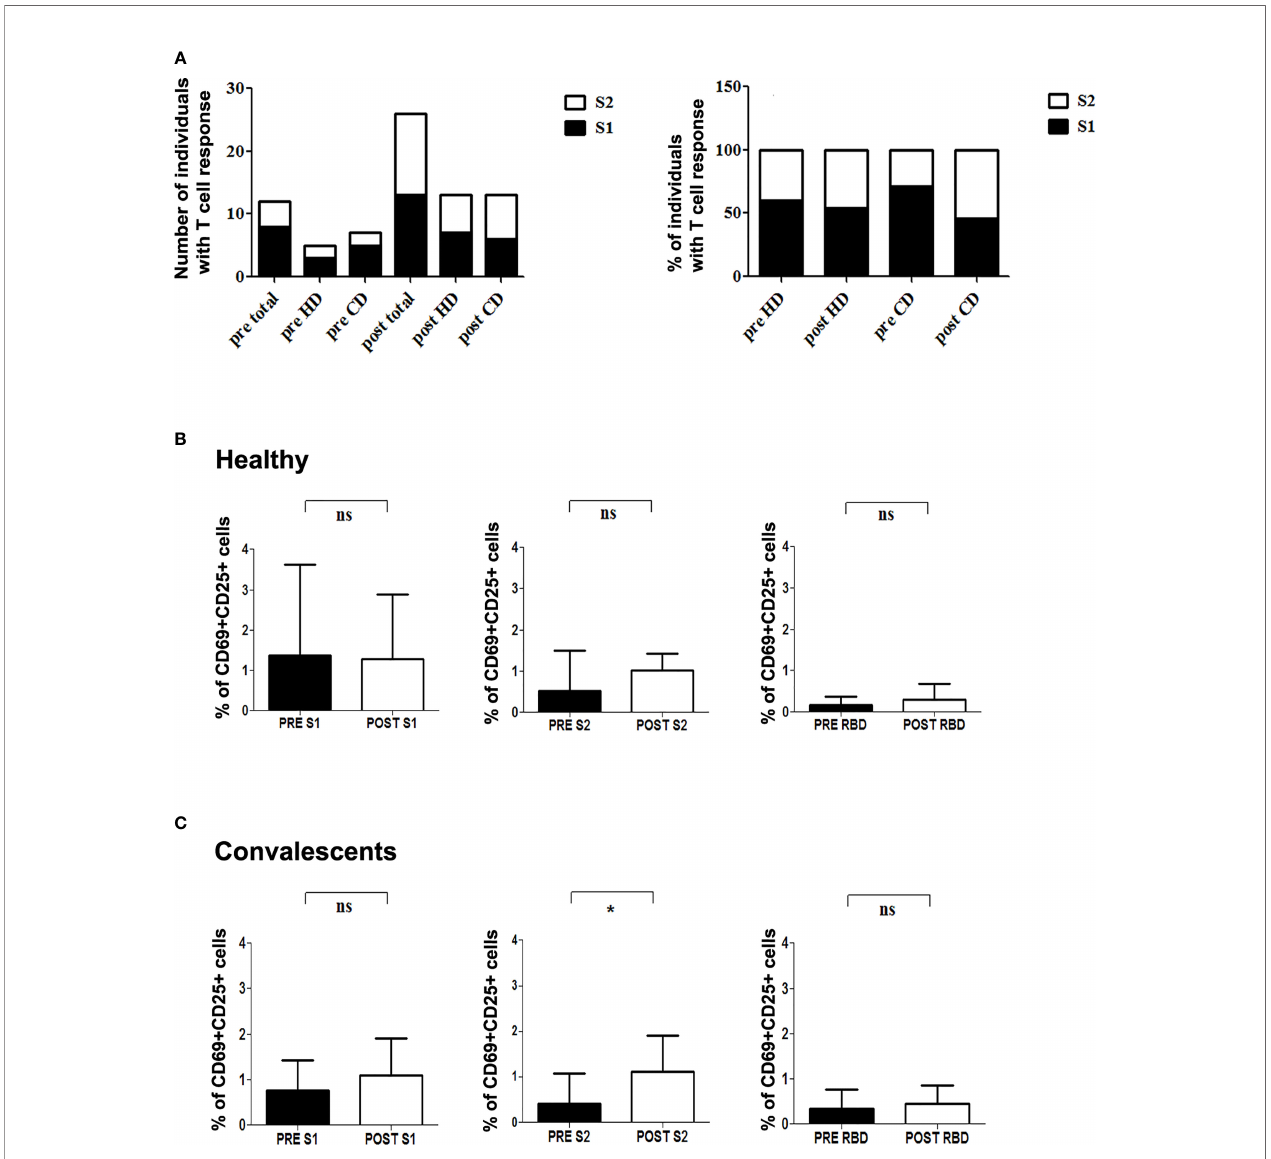
FIGURE 3 | T cell reactivity to SARS-CoV-2 S protein in healthy and convalescent individuals before and after vaccination. (A) Left , absolute number of individuals with CD4+ reactive lymphocytes against S1 (black) and S2 (white) before (pre) and after (post) vaccination. Right , Relative percentage of S-protein positive donors reactive for either S1 (black) or S2 (white) in each condition. (B, C) Graphics show speci fi c percentage of HD (B) and CD (C) before (pre) and after (post) vaccination in the presence of S1 (left), S2 (middle) and RBD (right) peptide pools. Statistical analysis was performed with the paired Student ’ s t-test. *p=0.045; ns, not signi fi